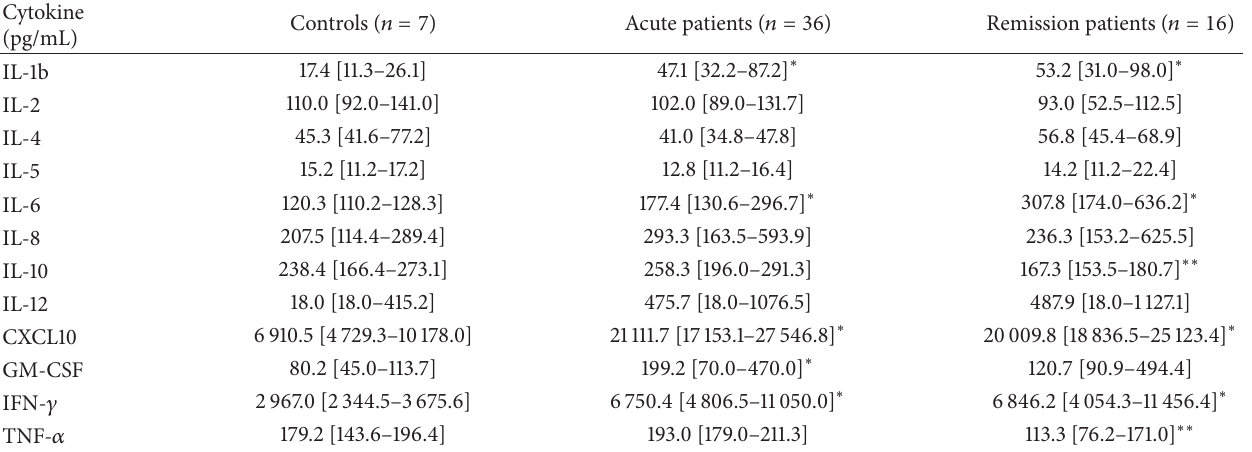
Table 4: Serum cytokine activation in adult CD (median [25th–75th